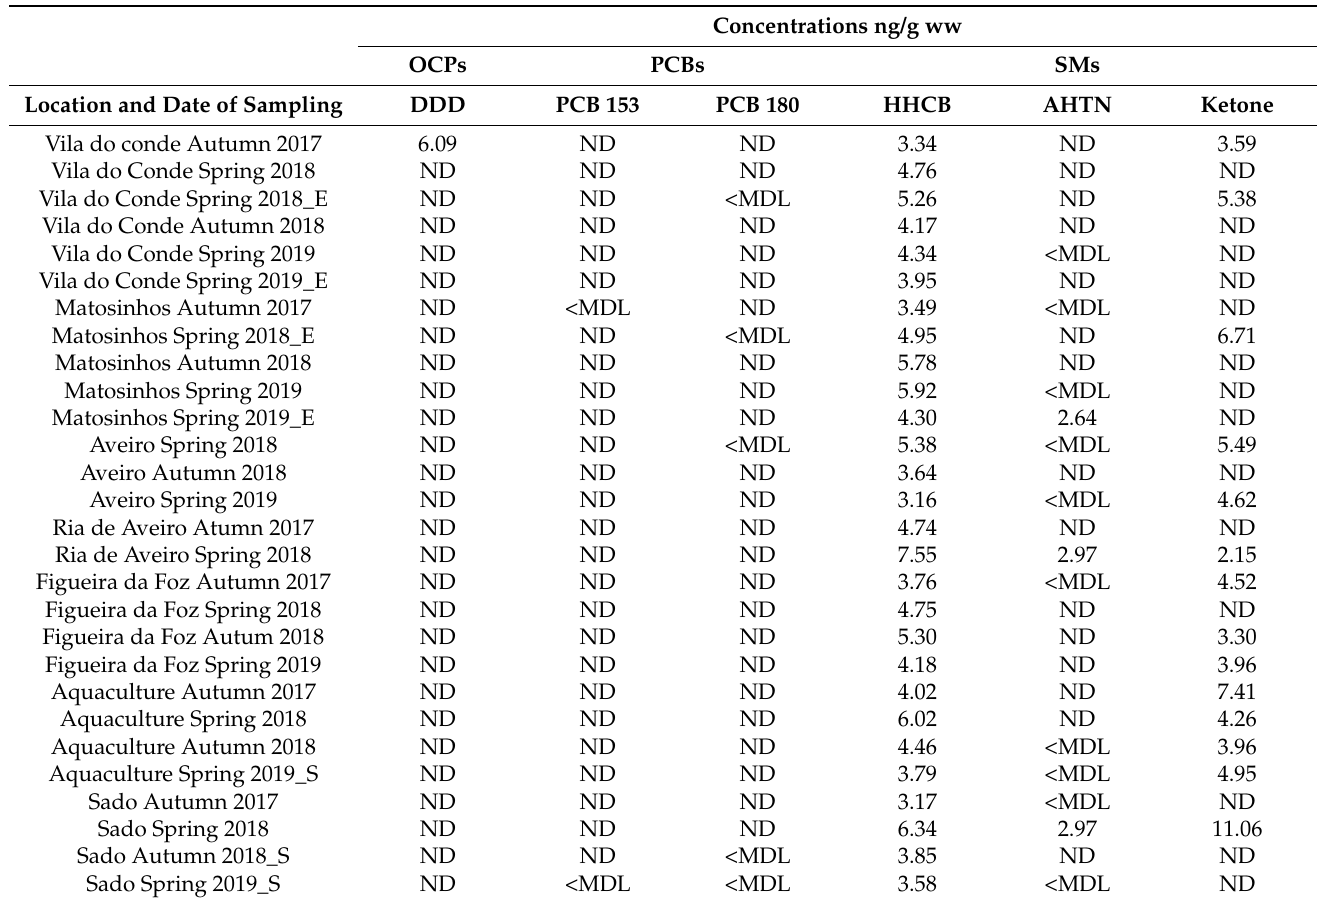
Table 2. Levels for the pollutants found in shrimp samples (ng/g ww) from Portugal.